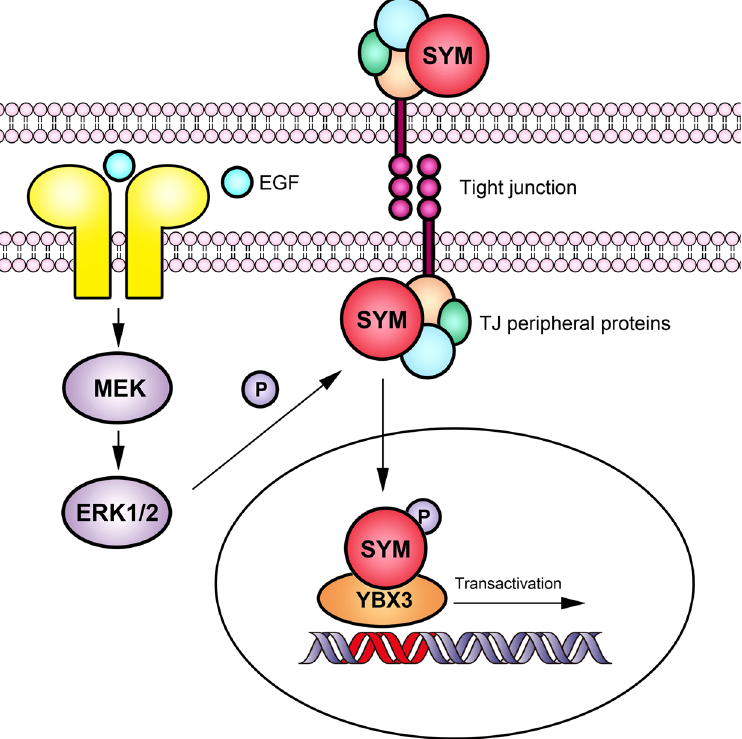
Figure 7. Schematic representation of the ERK-dependent regulation of symplekin